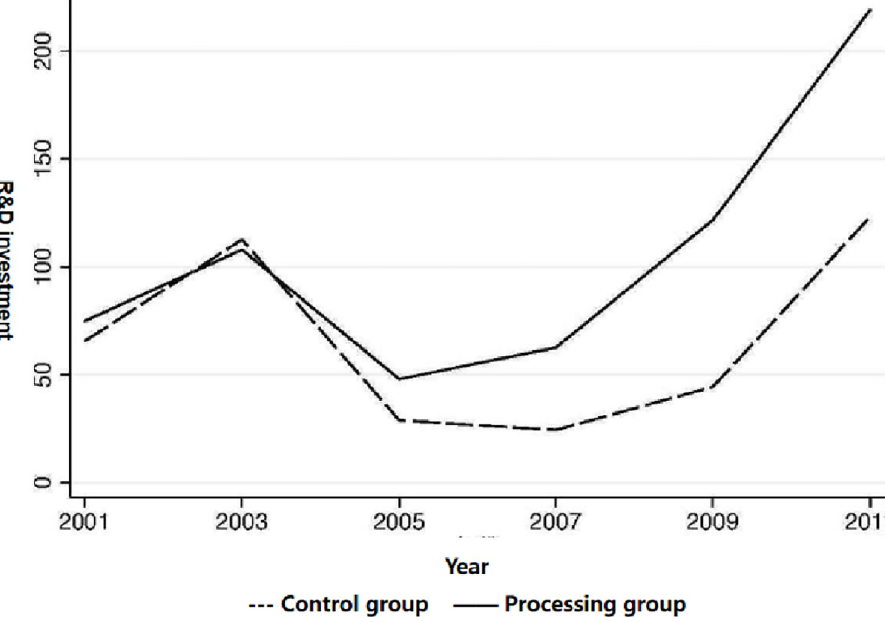
Fig 1. Trends in the evolution of R&D investment of enterprises in the treatment and control groups (unit: Million yuan).